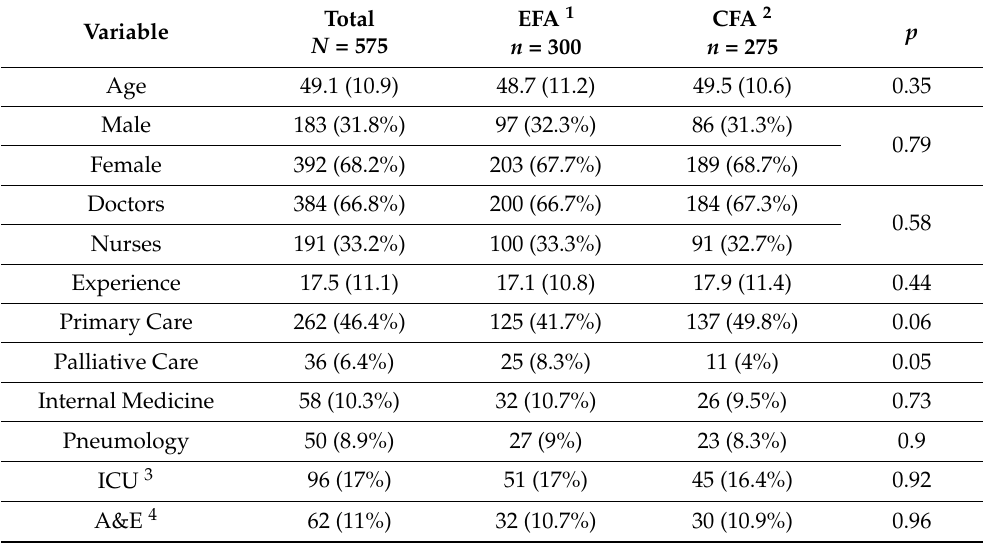
Table 1. Characteristics of the study